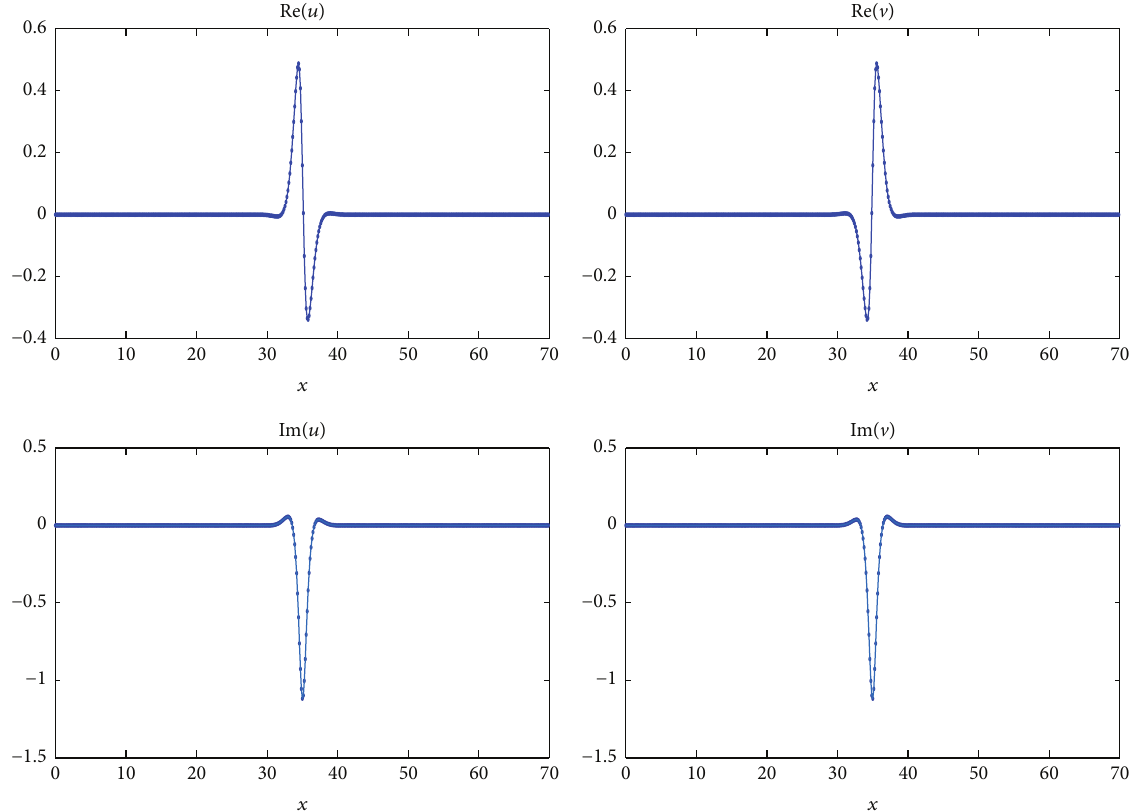
Figure 5: Real and imaginary parts of the vector soliton (𝑢, V ) of system (1) at 𝜉 = 20 . Solid line: numerical solution (𝑢, V ) of system (1) using the numerical scheme in [37]. Pointed line: expected soliton computed using